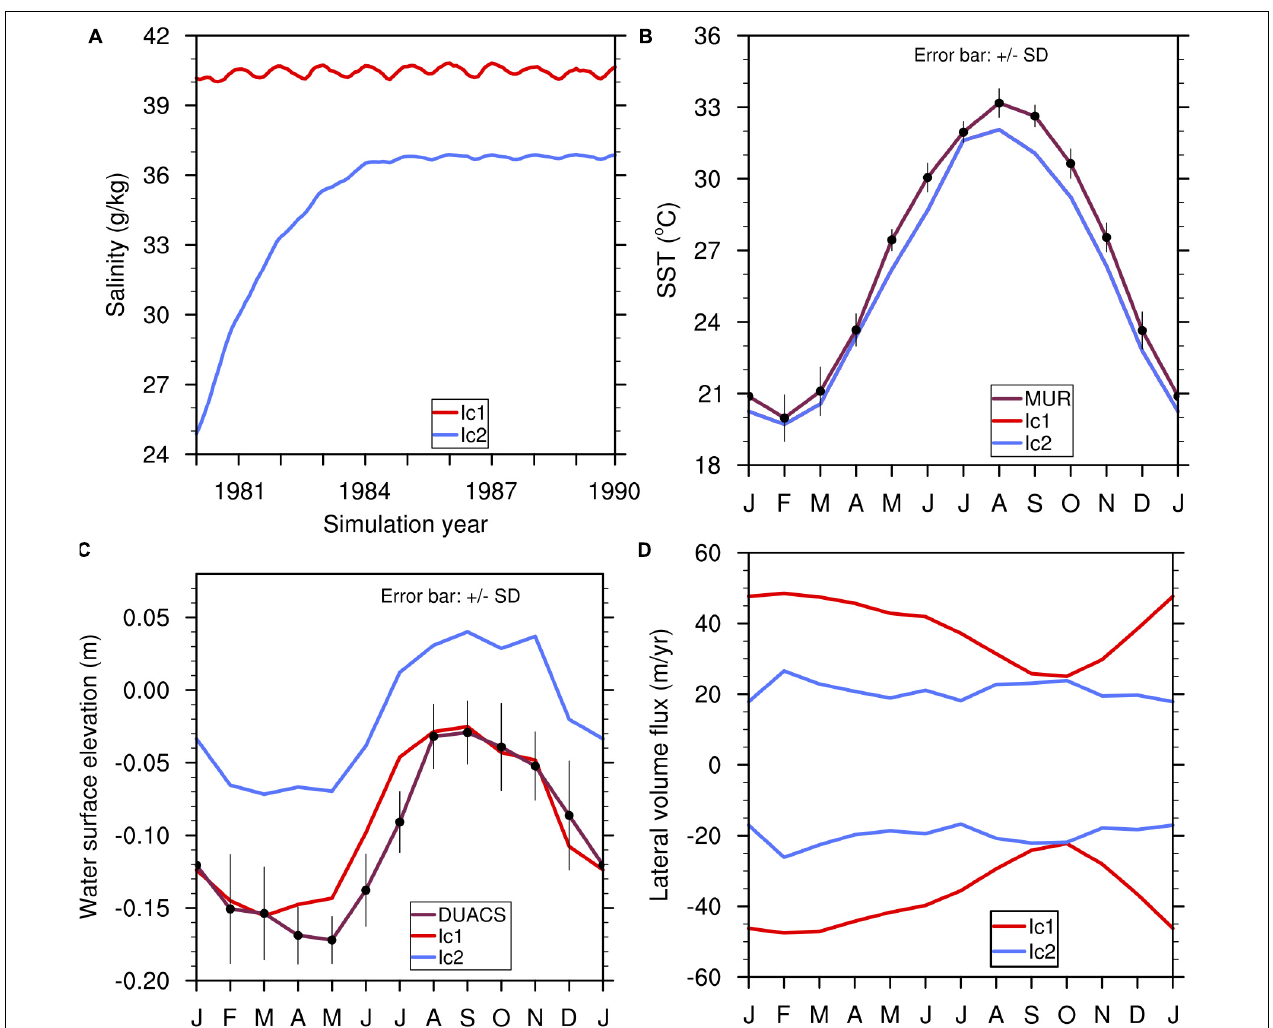
FIGURE 5 | Gulf dynamical properties in Ic1 and Ic2 equilibrium. (A) Simulated monthly basin-average salinity. (B) Simulated climatological monthly basin-average SST compared to JPL MUR analysis SST. (C) Simulated climatological monthly Gulf WSE (relative to Indian Ocean) compared to satellite-derived WSE. (D) Simulated climatological monthly lateral volume flux into the Gulf from the Indian Ocean (positive) and out of the Gulf to the Indian Ocean (negative) in the vertical overturning circulation.